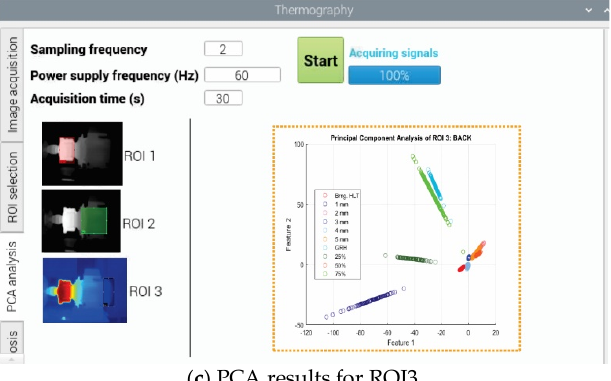
Figure 15. Results observed in the tab PCA analysis for the selected ROI for outer-race faults in the rolling bearings and gear wear into the gearbox of the induction motor, in ( a ) for the ROI1, in ( b ) for the ROI2, and in ( c ) for the ROI3.